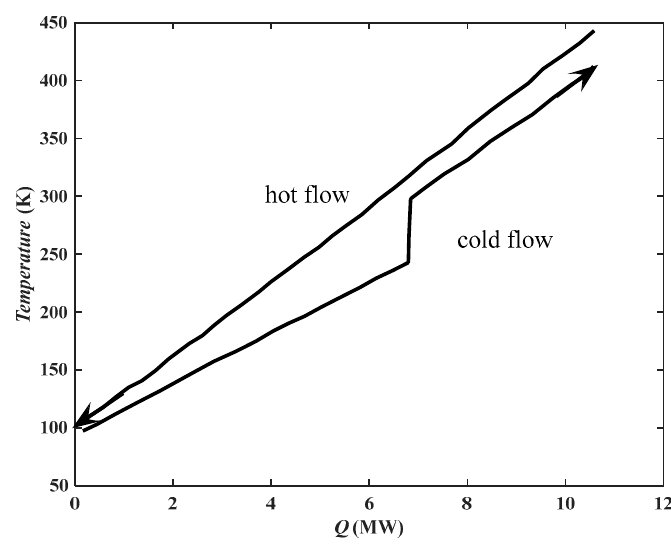
Figure 8. The composite curve of the flare recovery process.